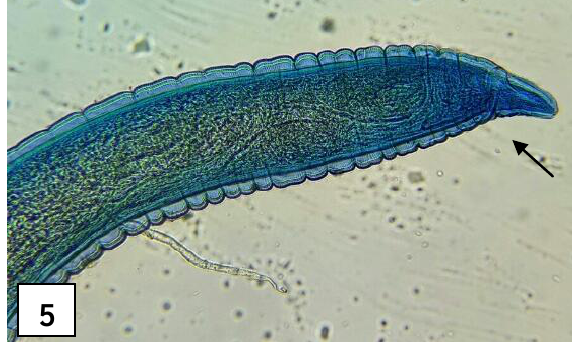
Figure, 5: Posterior end of the female with appearance of the anal pore ventrally (x10)